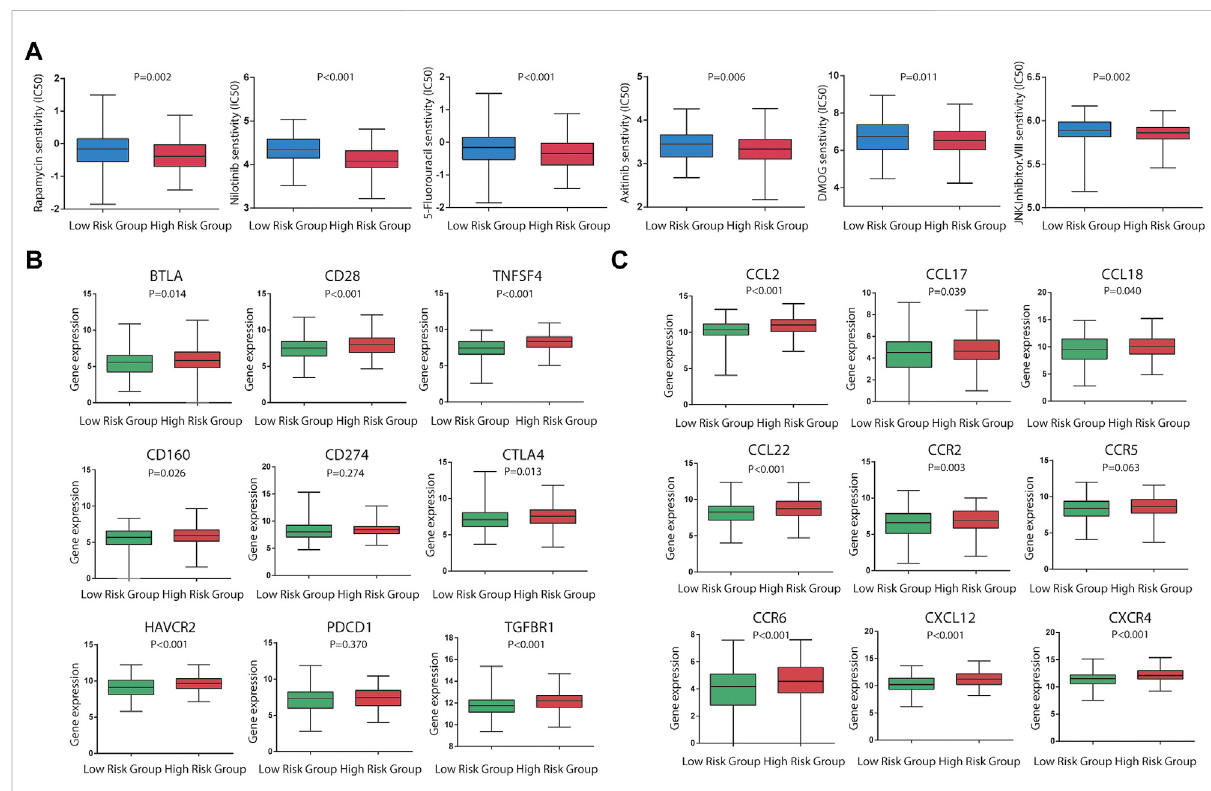
FIGURE 7 Signi fi canceoftheCSRG-basedsignatureinchemotherapyandimmunotherapy. (A) Sensitivityperformanceofsixchemotherapyagentsinthe high-risk and low-risk subsets (rapamycin, nilotinib, 5- fl uorouracil, axitinib, DMOG, and JNK inhibitor VIII). (B) Differential expression levels of nine immune checkpoint molecules (CD28, CTLA4, CD274, HAVCR2, BTLA, TNFSF4, CD160, PDCD1, and TGFBR1) between the high-risk and low-risk patients. (C) Differential expression levels of nine chemokines (CCL2, CCL17,